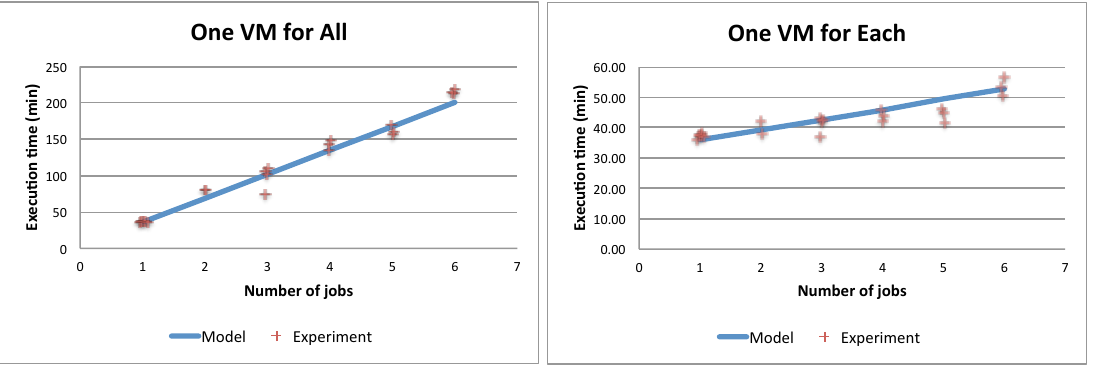
Figure 10. Comparison of the model and experimental system response